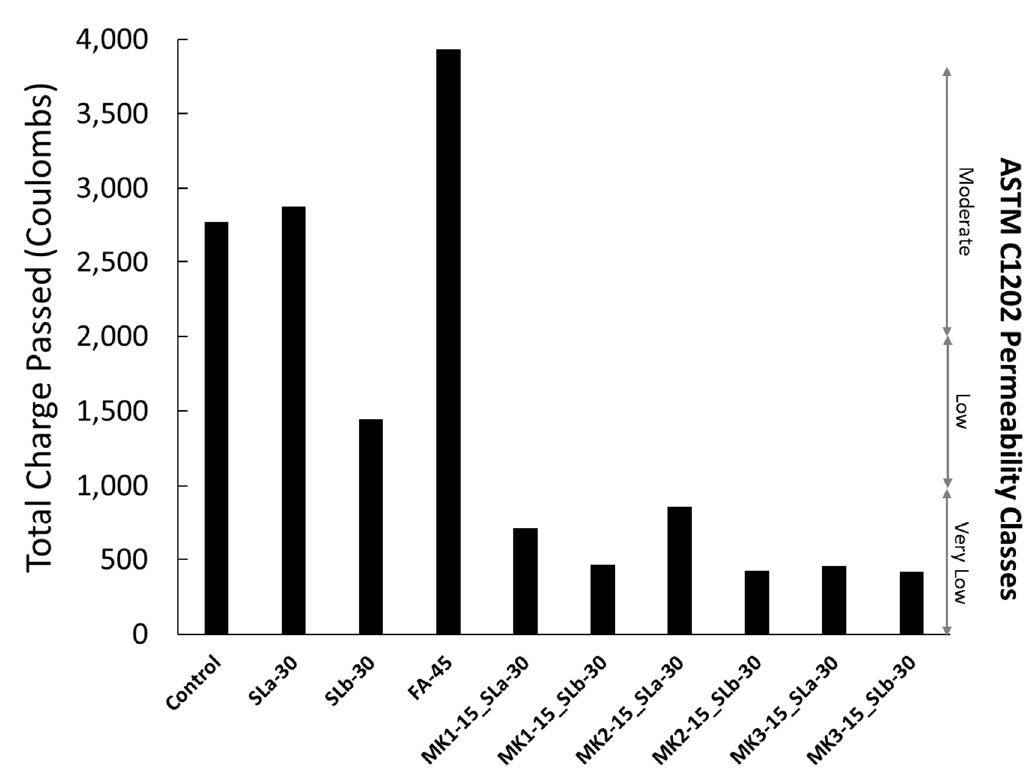
Figure 5. Permeability of non-metakaolin binary and ternary SCM mixtures by RCPT.